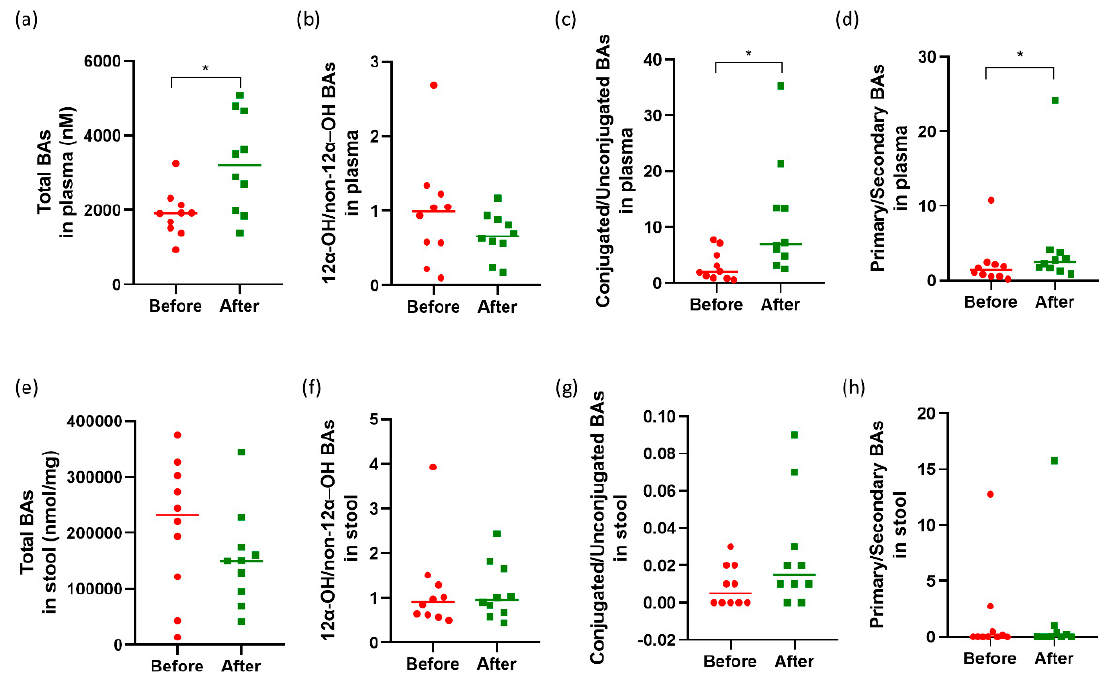
Figure 4. Changes in total and classification ratios of bile acids (BAs) in plasma and feces after YH1 treatment. Total BAs and classification ratios of BAs in plasma and feces before (red circles) and after (green squares) YH1 treatment in the ten patients are shown as scatter plots. The line in the graph represents the median value. The Wilcoxon signed-rank test was used to determine whether there was a statistical difference before and after treatment (* p < 0.05). ( a ) Total plasma BAs increased significantly after YH1 treatment. ( b ) The ratio of 12 α -hydroxylated to non-12 α -hydroxylated BAs didn’t show significant change. Changes in the ratio of BA classification were only significantly elevated in plasma ( c ) conjugated/unconjugated BAs and ( d ) primary/secondary BAs. ( e ) Total stool BAs had no significant change before and after YH1 treatment. In addition, no significant difference was found in the analysis of fecal BA profiles ( f – h ) before and after treatment. 12 α -OH/non-12 α -OH BAs, 12 α -hydroxylated/non-12 α -hydroxylated bile